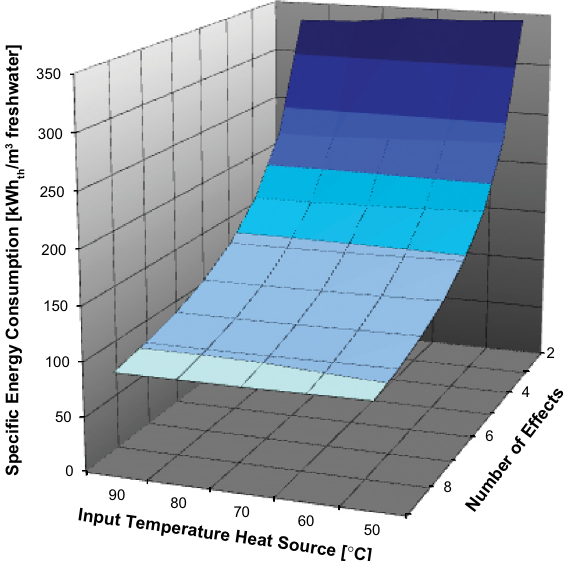
Figure 3. Dependency of the specific energy consumption per m 3 freshwater on the heat source input temperature and the number of effects, shown for an example standard